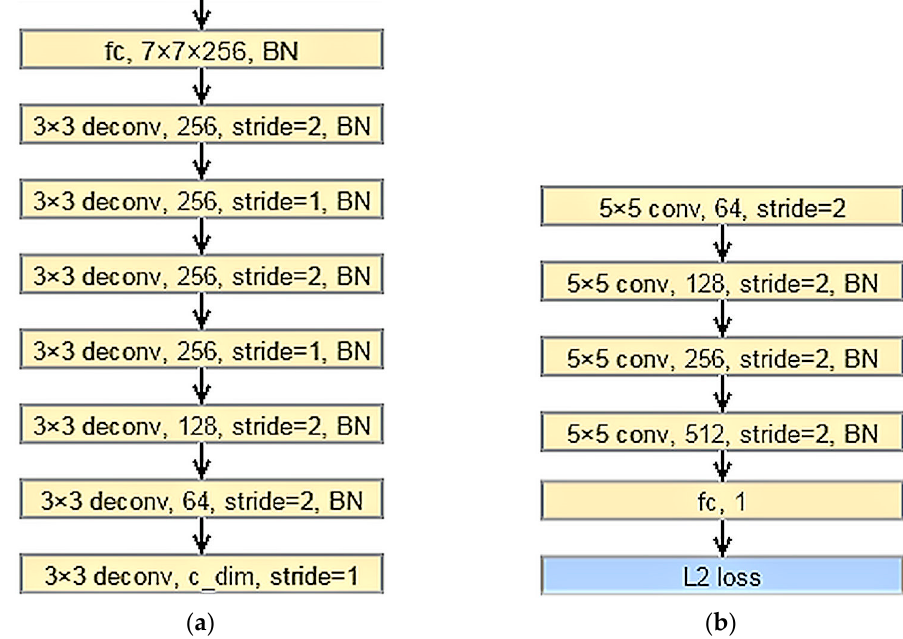
Figure 10. Model architecture used for the LSUN dataset to compare the obtained results: ( a ) the generator; and ( b ) the discriminator.